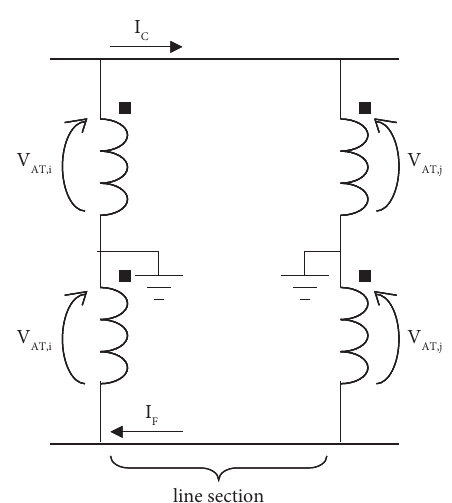
Figure 5: Sketch to illustrate the deduction for type-3cells.